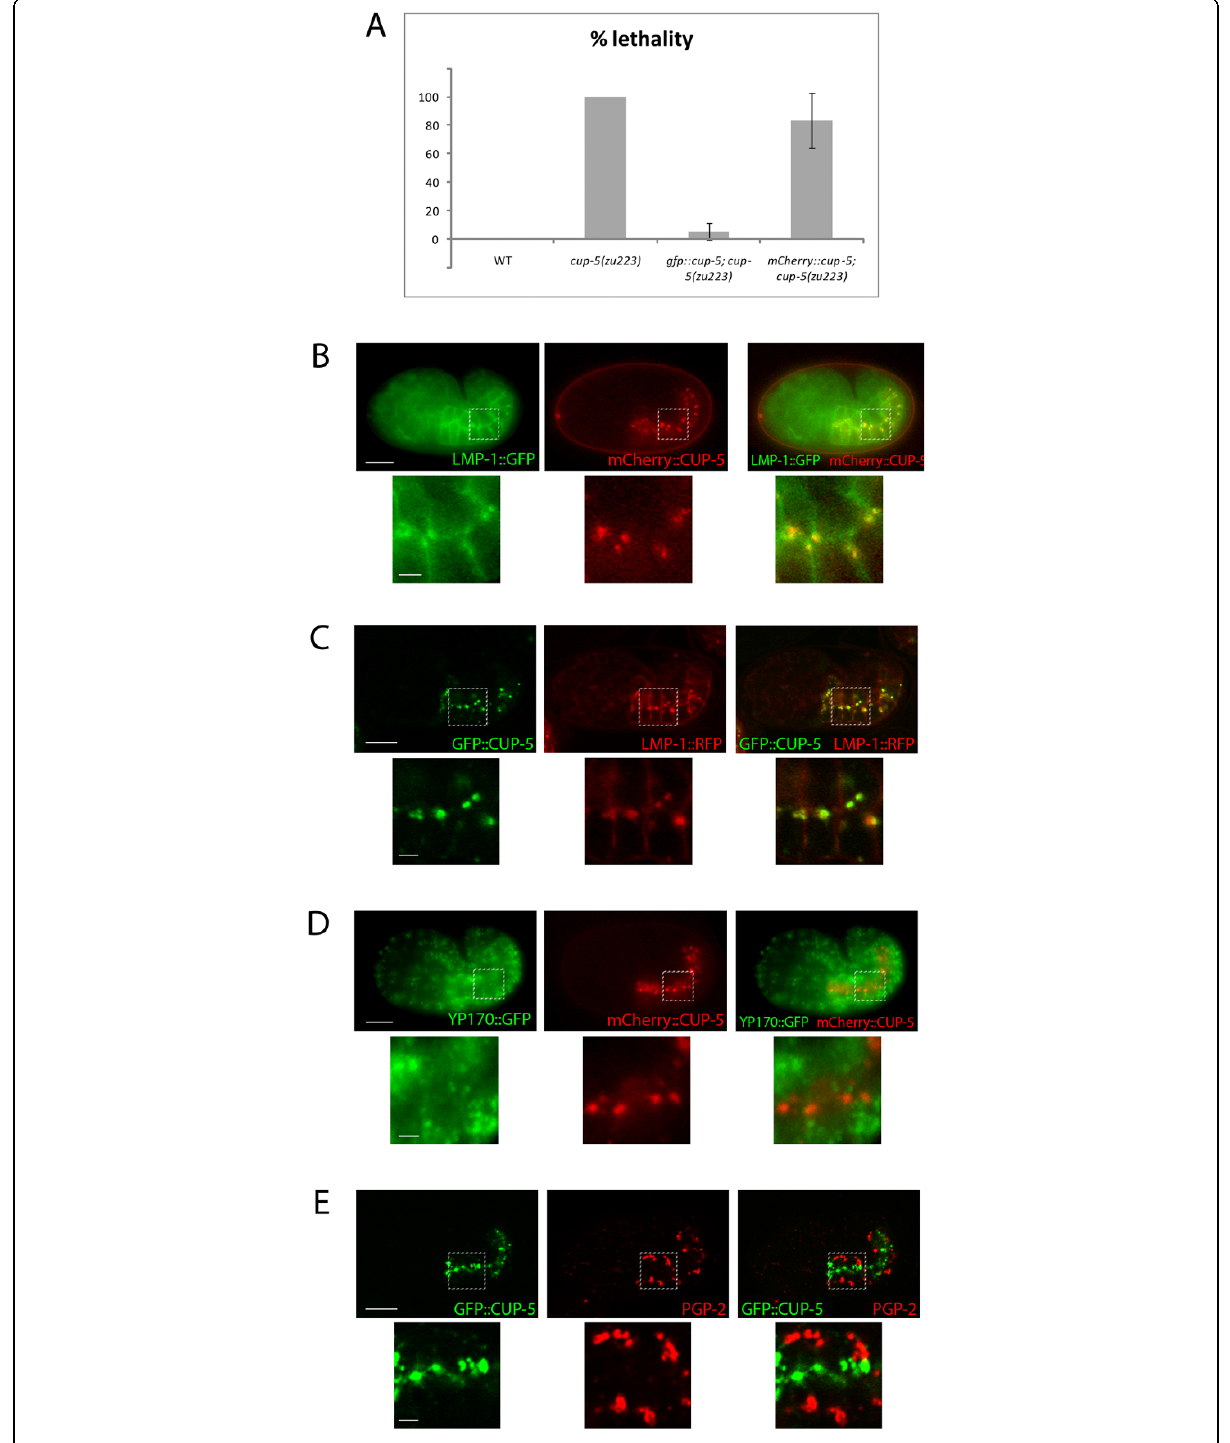
Figure 2 CUP-5 protein localization in developing intestinal cells . A) Percent lethality of WT, cup-5(zu223) , cup-5(zu223) ; P elt-2 :: gfp::cup- 5 and cup-5(zu223) ; P elt-2 :: mCherry::cup- 5 embryos. Error bars represent the 95% confidence intervals for significance. B) Epifluorescence images of a wild type embryo that expresses LMP-1::GFP and mCherry::CUP-5. C) Confocal images of a wild type embryo that expresses GFP::CUP-5 and LMP- 1::TagRFP(S158T). D) Epifluorescence images of a wild type embryo that expresses YP170::GFP and mCherry::CUP-5. E) Confocal images of a wild type embryo that expresses GFP::CUP-5 and immunostained to detect PGP-2. Bottom panels are magnified images of the regions indicated in the top panels. Scale bars in whole embryo images represent 10 μ m; scale bars in magnified images represent 2 μ